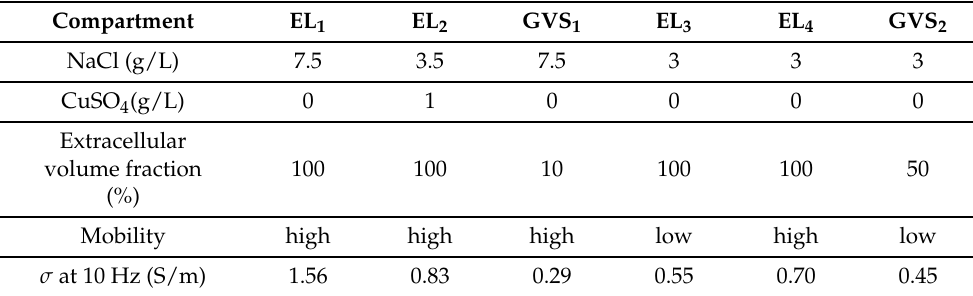
Table 1. Compositions of two conductivity phantoms. The electrolyte and giant vesicle suspension are denoted as EL and GVS, respectively. EL 1 , EL 2 , and GVS 1 were used in phantom #1. EL 3 , EL 4 , and GVS 2 were used in phantom